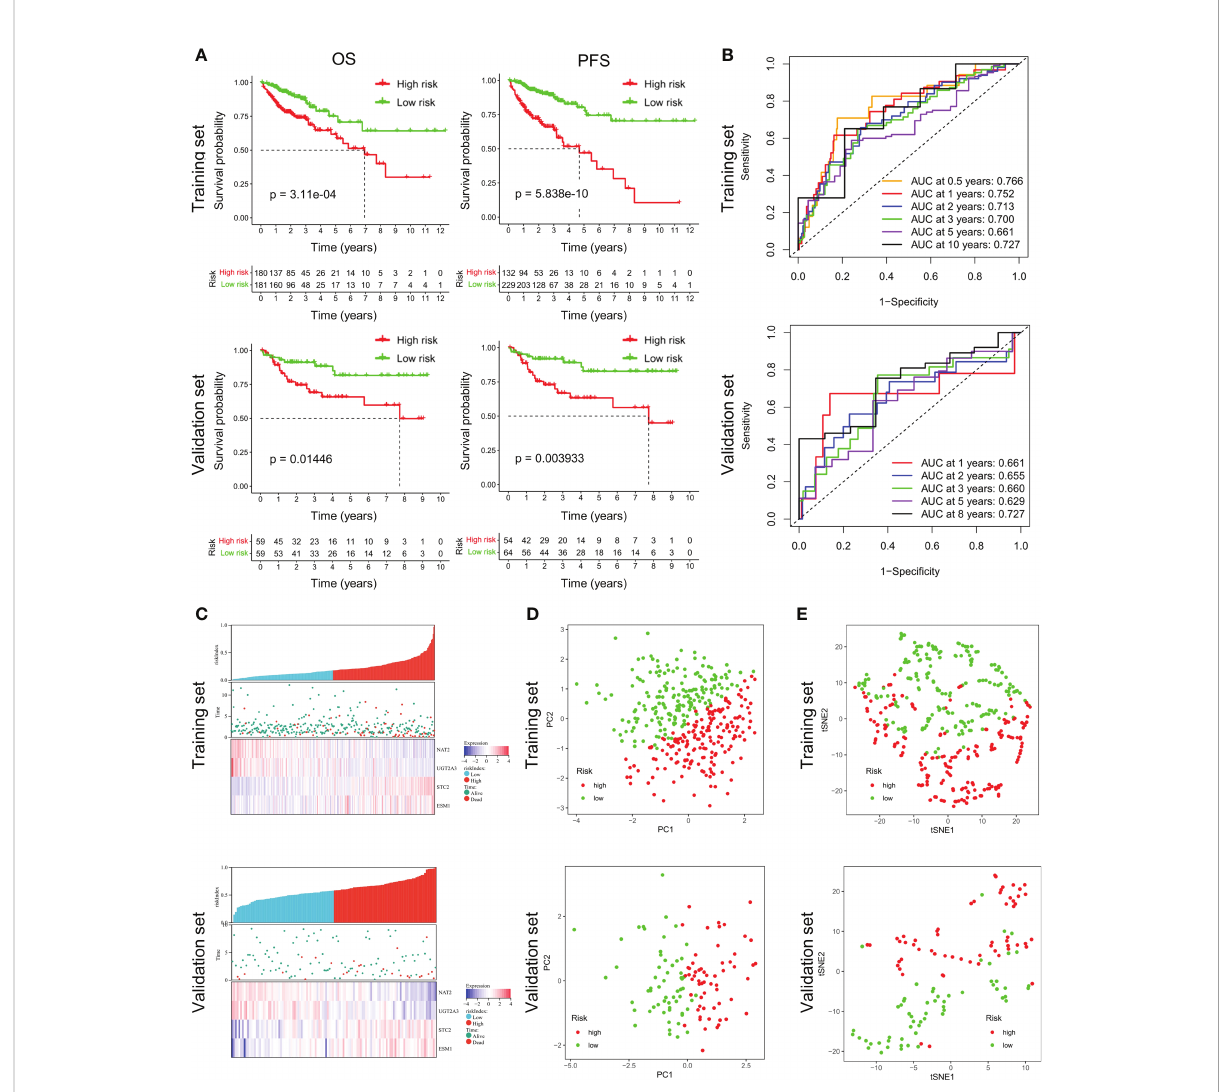
FIGURE 2 Survival analysis of CRC patients in the training and validation datasets. (A) Respective Kaplan-Meier OS and PFS curves in the training and validation datasets. (B) Time-dependent ROC curves for CRC patients at the time points of 0.5, 1, 2, 3, 5 and 10 (or 8) years. (C) RiskScore distribution, survival status, and expression heatmap of the selected four genes in the high- or low-risk groups. (D, E) PCA and t-SNE analysis con fi rmed the clustering of combined metabolism- and immune-related